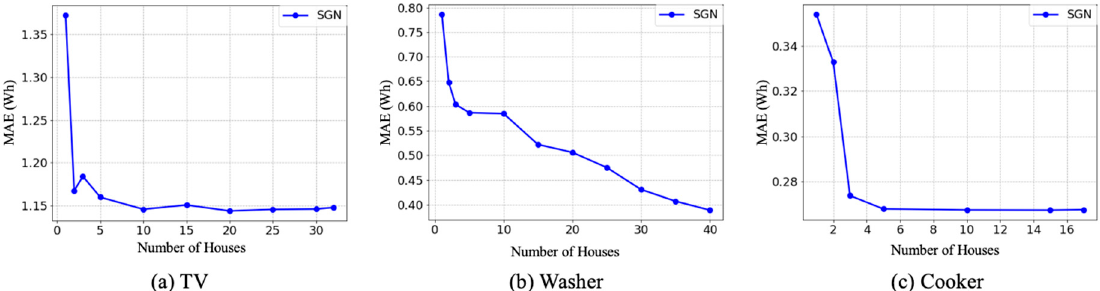
Figure 13. Sensitivity of the regression algorithm to the number of distinct houses used in the training data. As the number of houses increases, the test performance tends to improve. Owing to the limitation in the dataset and five-fold cross validation setup, up to 32, 40, and 17 houses were investigated for TVs, washers, and rice cookers, respectively.